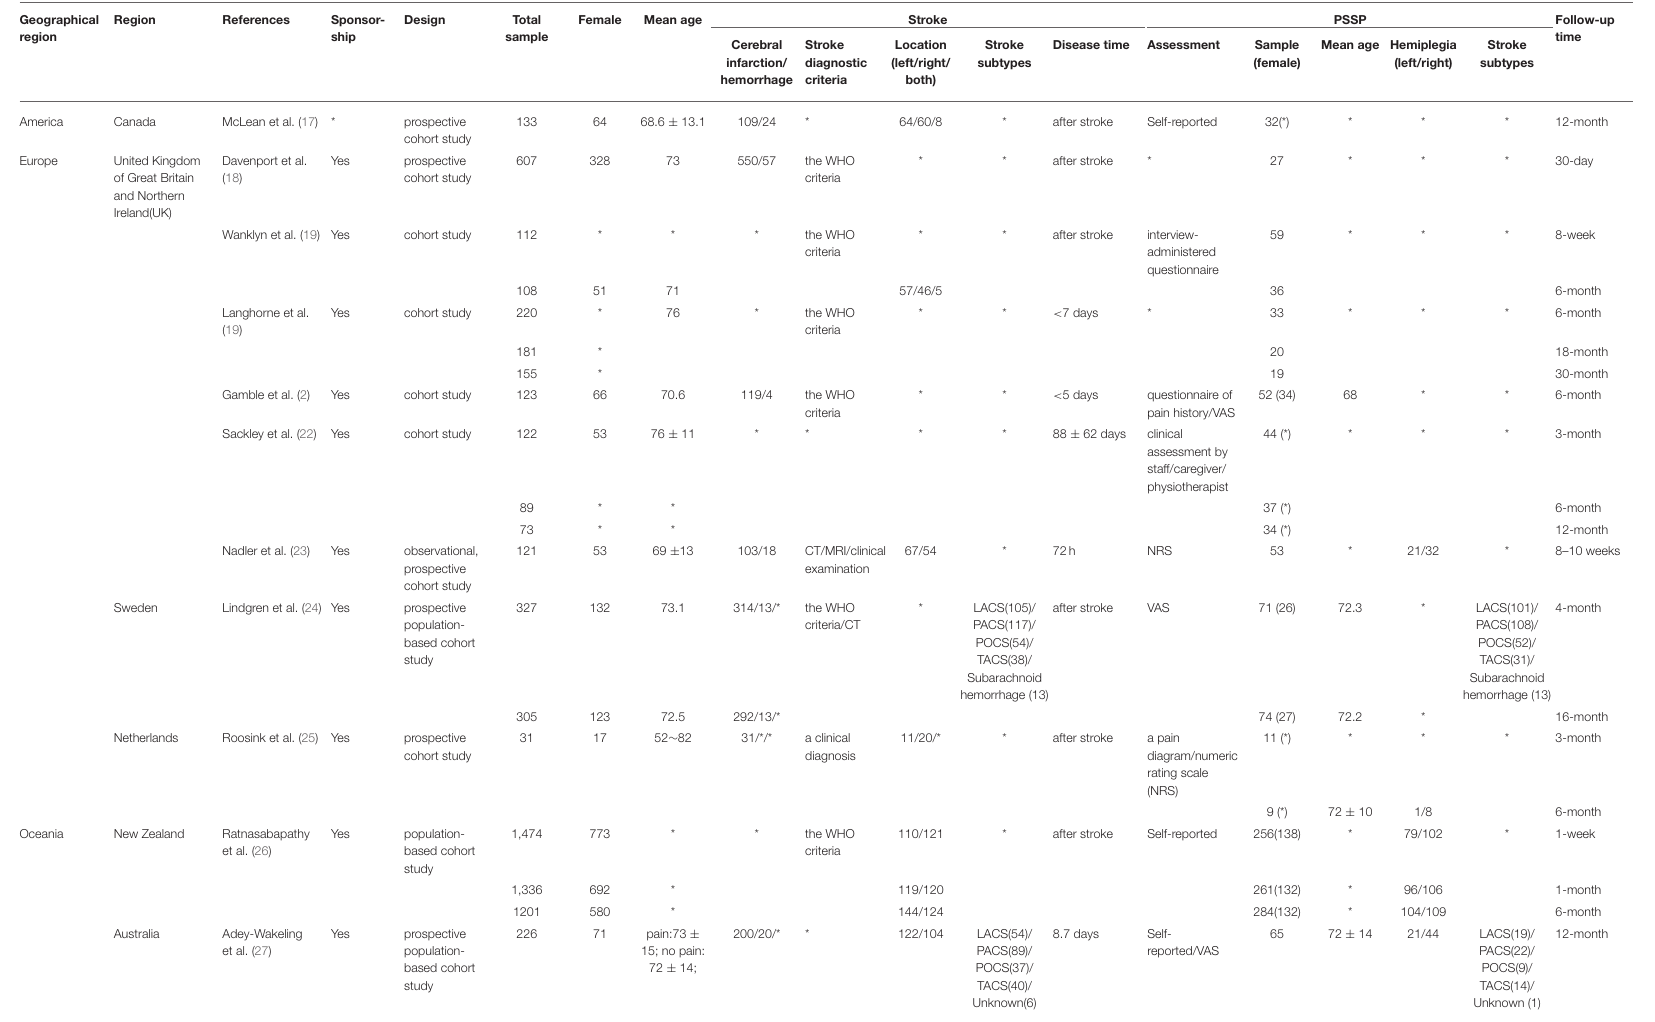
VAS, Visual Analog Scale; BNS, Numerical Box-21 Scale; NRS, Numeric Rating Scale; NPRS, Numerical Point Rating Scale; SPADI, Shoulder Pain and Disability Index; PPTs, Pressure Pain Thresholds; LACS, Lacunar Syndromes; PACS, Partial Anterior Circulation Syndrome; POCS, Posterior Circulation Syndrome; TACS, Total Anterior Circulation Syndrome; * ,